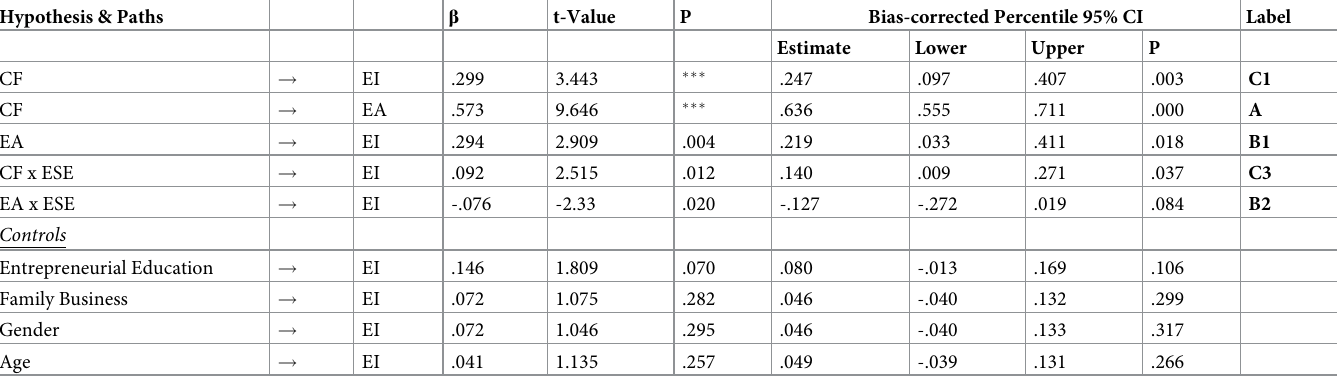
Table 4. Direct, indirect & conditional effects. Hypothesis & Paths